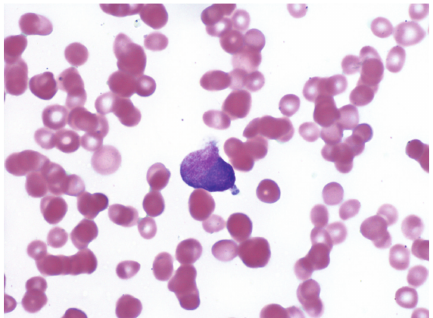
Figure 3: Bone marrow biopsy showing increased granular